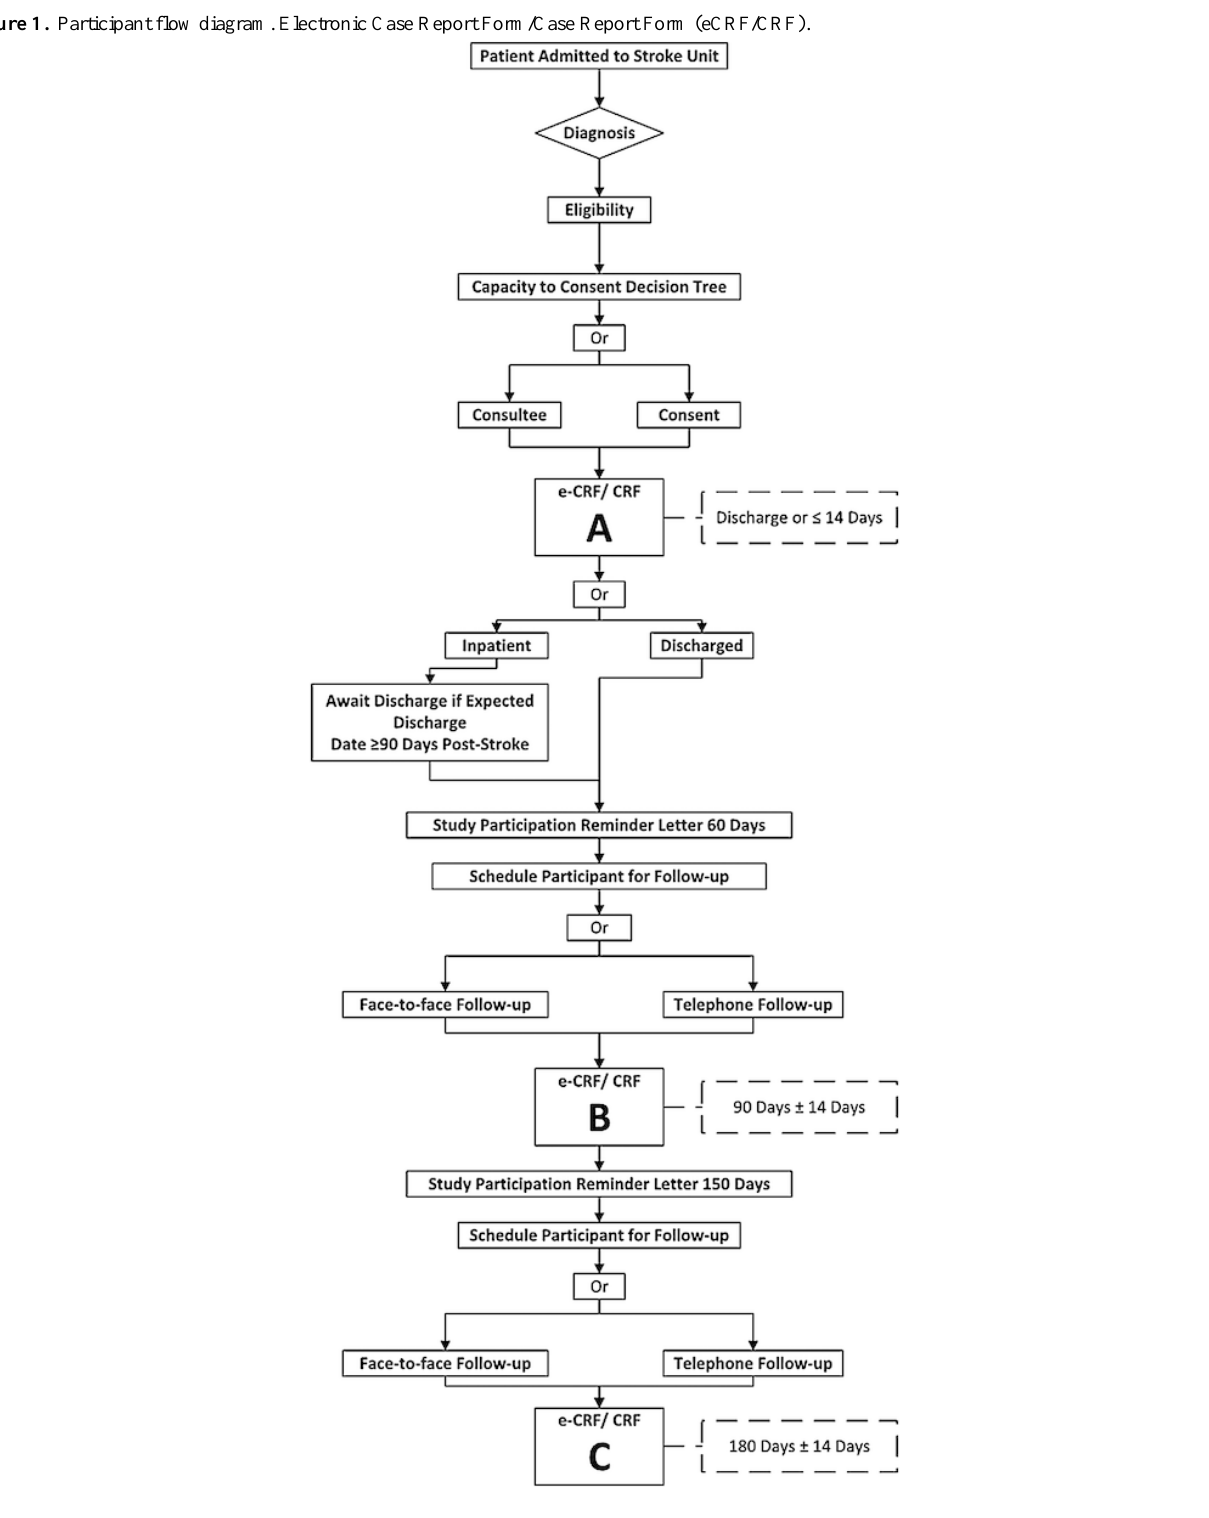
Figure 1. Participant flow diagram. Electronic Case Report Form/Case Report Form